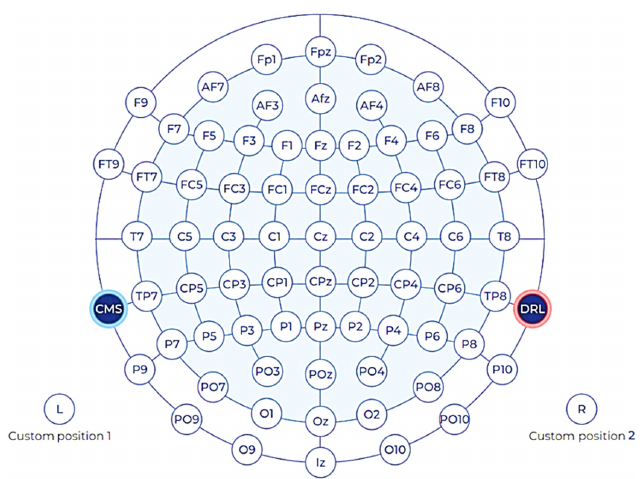
Figure 2. Electrode placement for 32 channels, based on a 10–20 system.